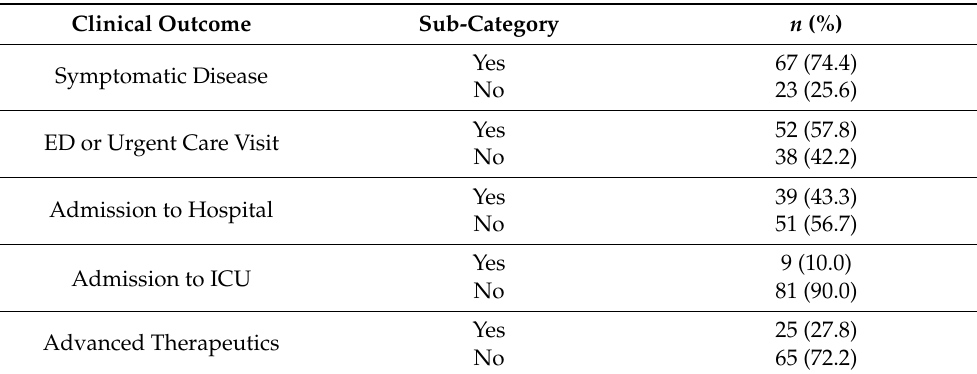
Table 3. Clinical Outcomes of Patients whom Tested Positive for